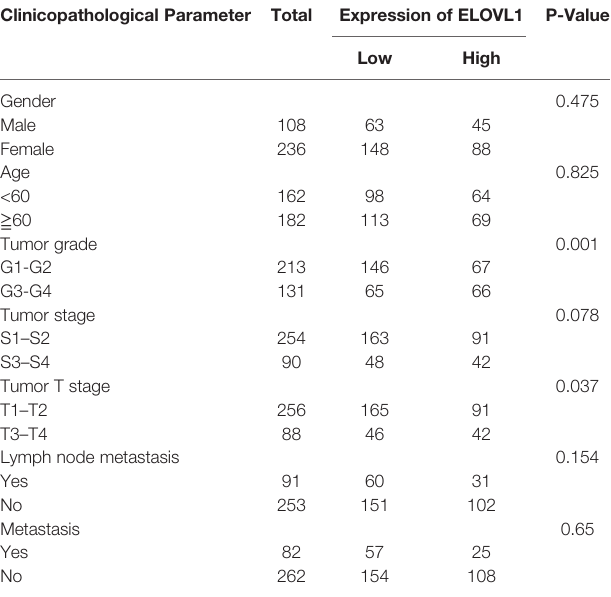
TABLE 1 | Correlation between ELOVL1 expression and clinicopathological characteristics of HCC patients in TCGA. Clinicopathological Parameter